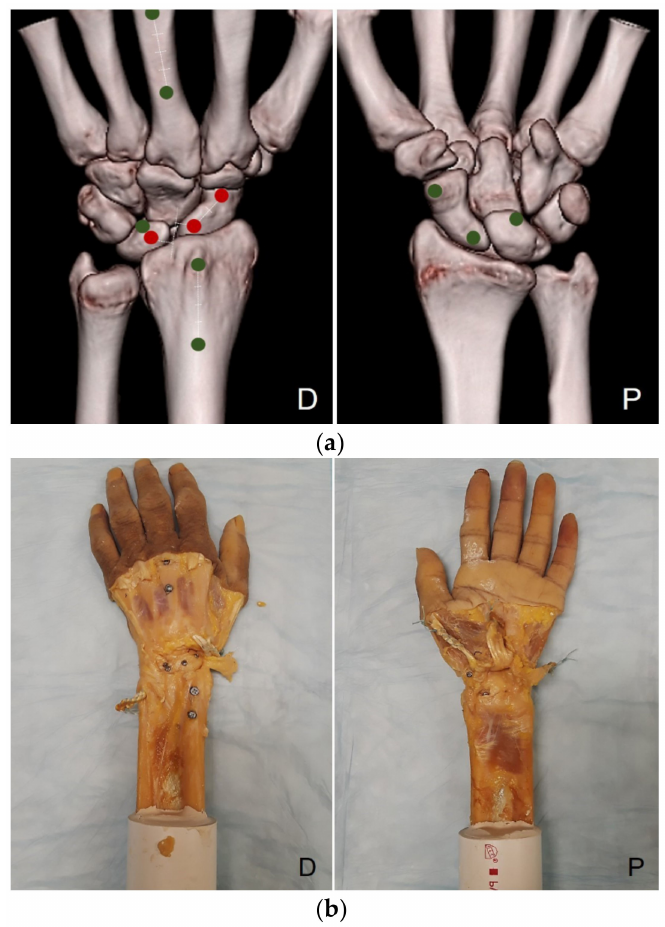
Figure 1. A consistent protocol utilizing anatomical landmarks was employed to place 11 digitizing markers. The markers on a computed tomography scan ( a ) and the cadaver ( b ). D, dorsal aspect; P, palmar